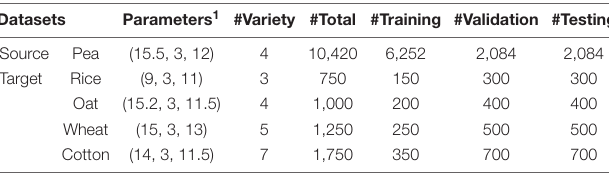
TABLE 1 | Description of the source and target datasets.